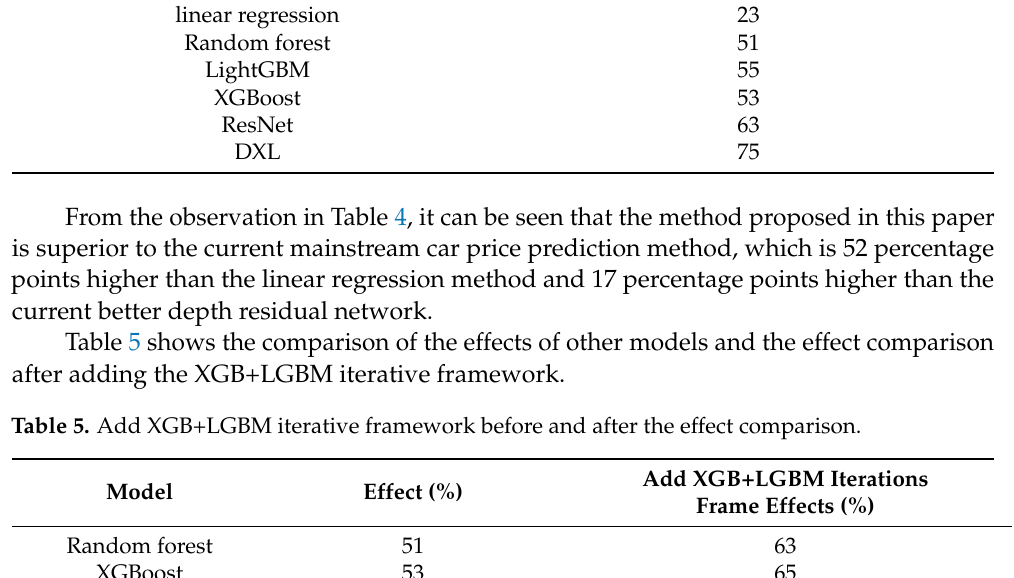
Table 5. Add XGB+LGBM iterative framework before and after the effect comparison.